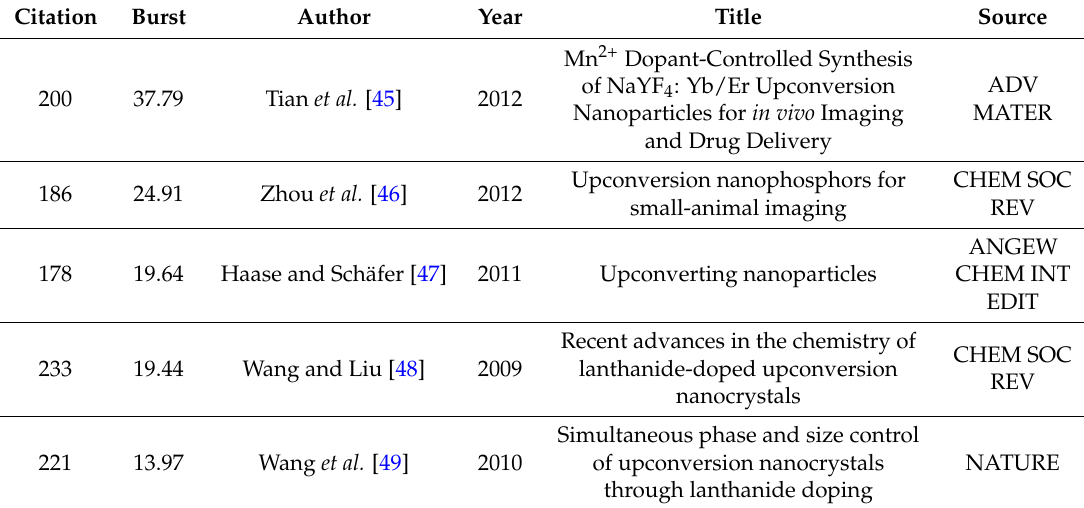
Table 4. Articles with the strongest citation bursts in cluster